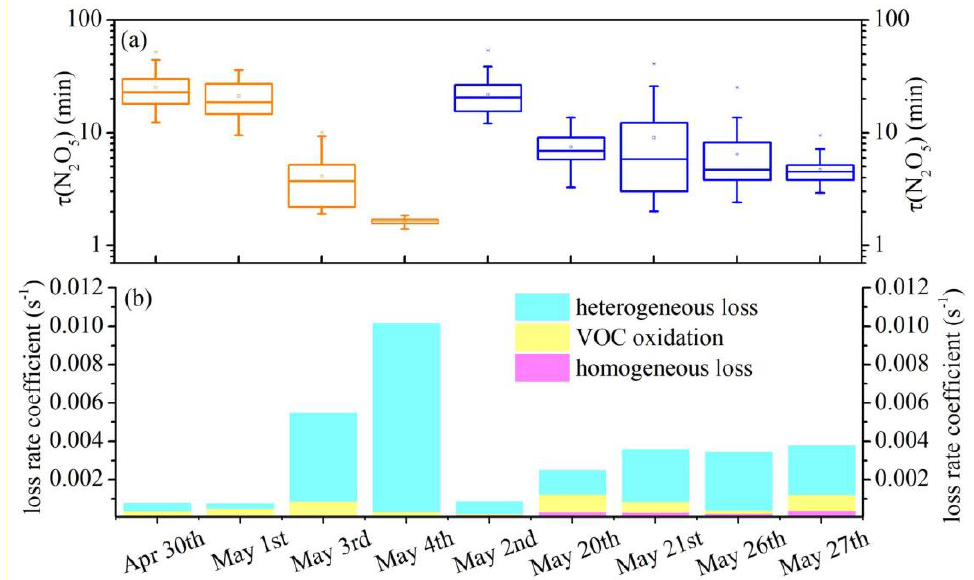
Figure 4. ( a ) N 2 O 5 lifetime and ( b ) N 2 O 5 loss rate coefficients in selected N 2 O 5 -rich or ClNO 2 -rich air masses. The upper and bottom whiskers show the 10% and 90% percentiles. The upper, middle, and bottom lines in the boxes denote the 75%, median, and 25% percentiles, respectively. The squares show the average values. Orange denotes light dust cases and heavy sand storm events, while blue represents urban air masses. The selected time periods were 20:00~04:00 local time (LT) for each night.